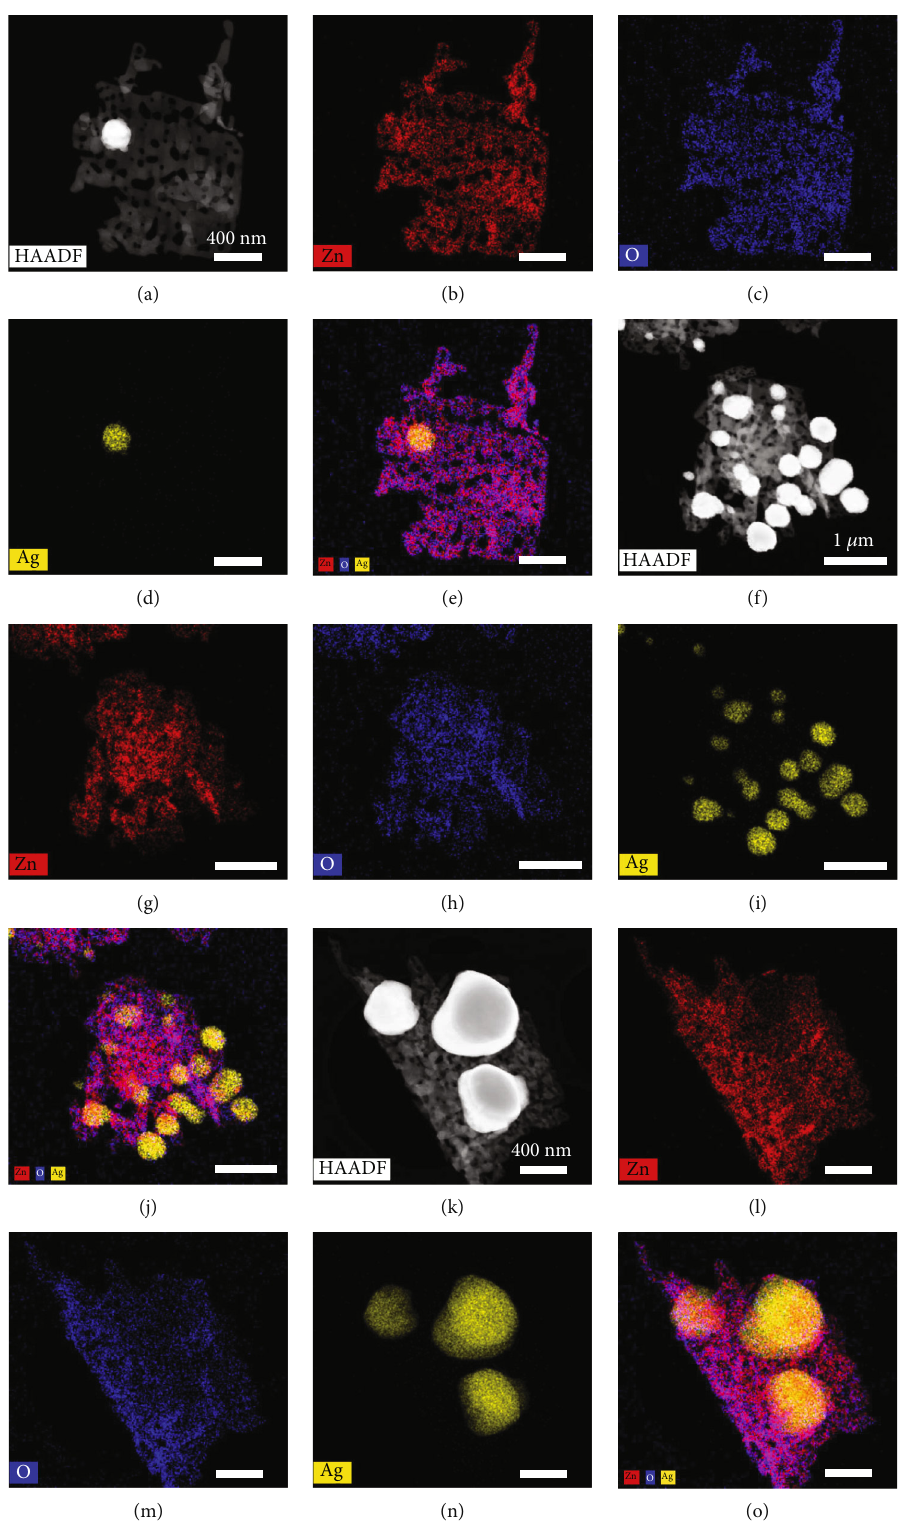
Figure 3: TEM elemental mapping of the (a – e) 1, (f – j) 3, and (k-o) 5 at% Ag-functionalized porous ZnO